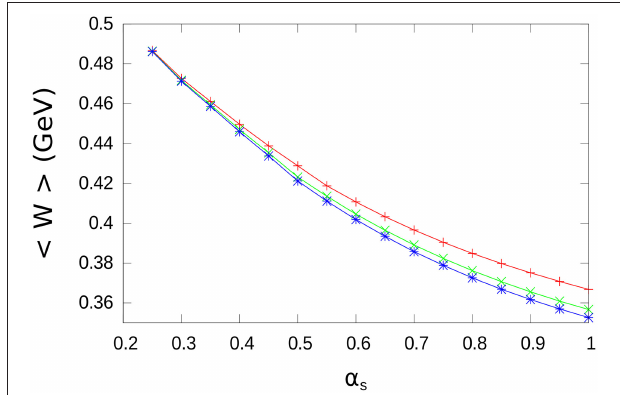
FIGURE 4 | The expectation values of the potential energy W ( r ) are plotted as a function of α s with the values of d shown in Figure 3 . The results of the numerical calculation are indicated by points, joined by lines for convenience. As before, red, blue, and green refer to exponential, Gaussian, and step-wise distributions, respectively.